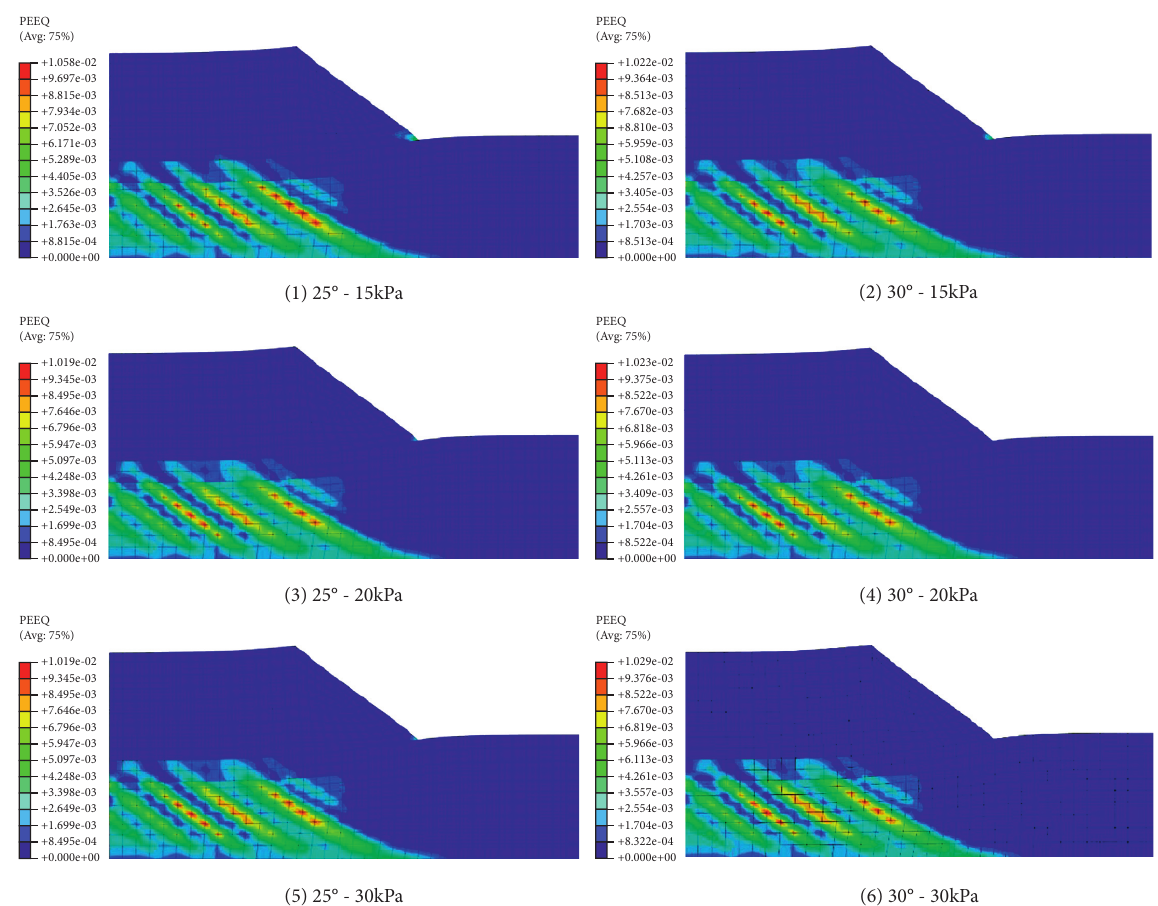
Figure 5: Effects of cohesion and internal friction angle. (a) 25 ° -15kPa. (b) 30 ° -15 kPa. (c) 25 ° -20 kPa. (d) 30 ° -20 kPa. (e) 25 ° -30kPa. (f) 30 ° - 30kPa.